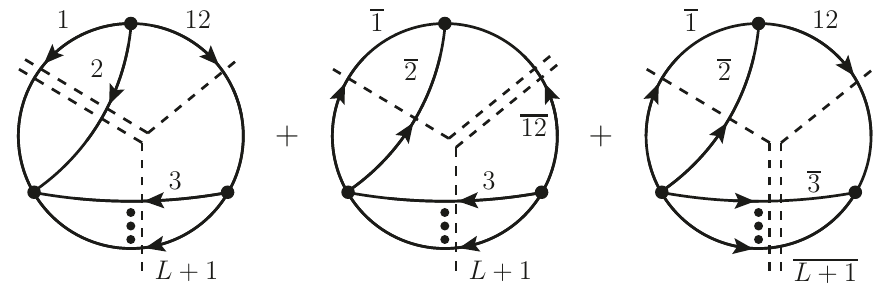
Figure 4 . Entangled causal thresholds of the NMLT topology. External momenta not